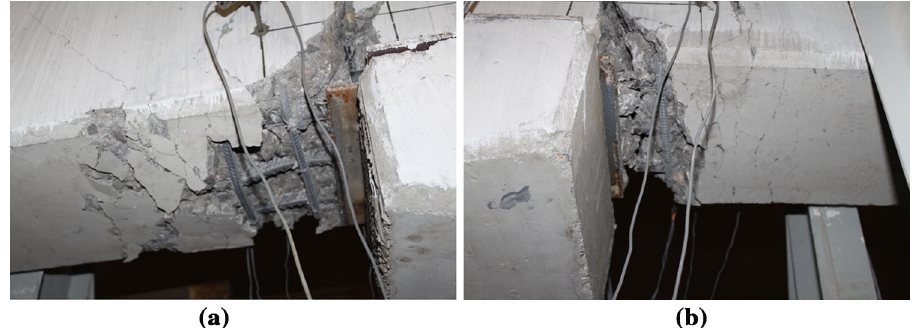
Fig. 15 a Initiation of rebar buckling at the left beam (Beam 1) and b the rupture of rebars at the right beam (Beam 2) for SP1 specimen at 2.2% top